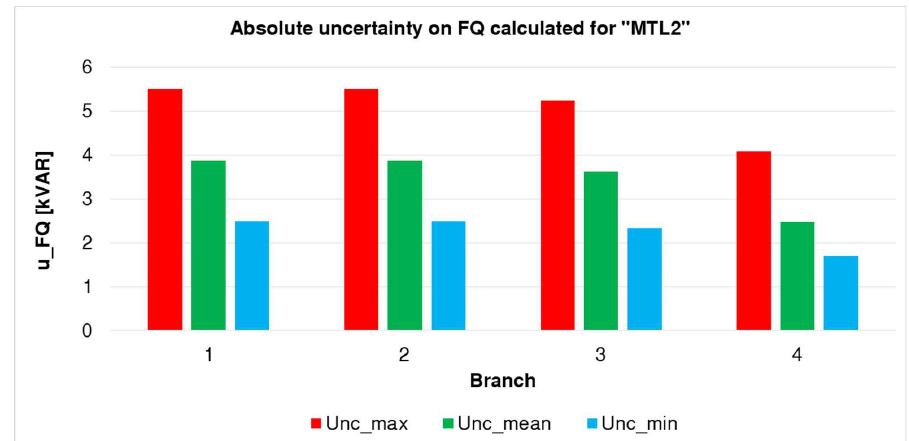
Figure 18. Maximum, average and minimum values of the relative uncertainties in the reactive power flows calculated of the “MTL2” line (31 May 2018).